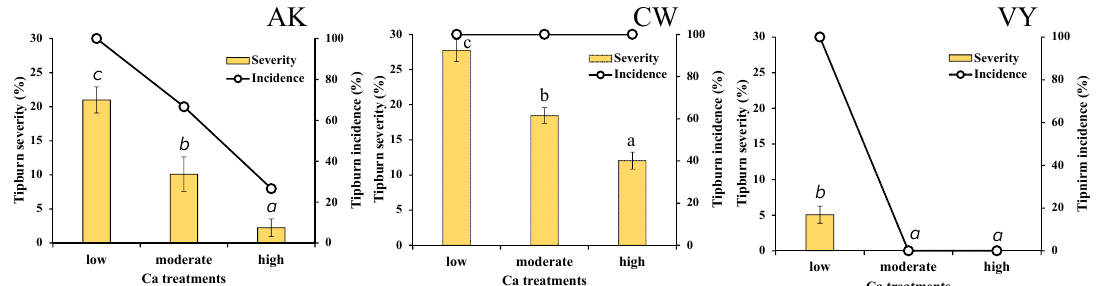
Figure 1. Tipburn severity and incidence for three lisianthus cultivars and Ca concentration treatments at the end of the experiment. Mean values ( n = 15) are shown, and significant differences among them are indicated by different letters (normal type: Tukey’s b test, p < 0.05; italic type : Dunnet T3, p < 0.05). Cultivars: ‘Azuma ‐ no ‐ Kaori’ (AK), ‘Celeb Wine’ (CW), ‘Voyage Yellow’ (VY).